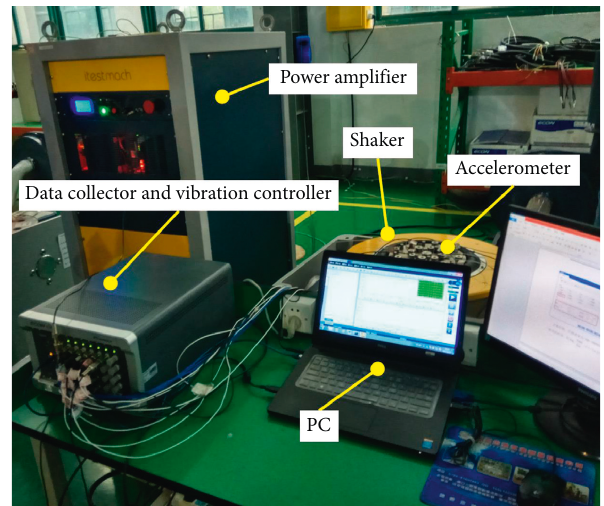
Figure 13: AVC system for SRS validation.